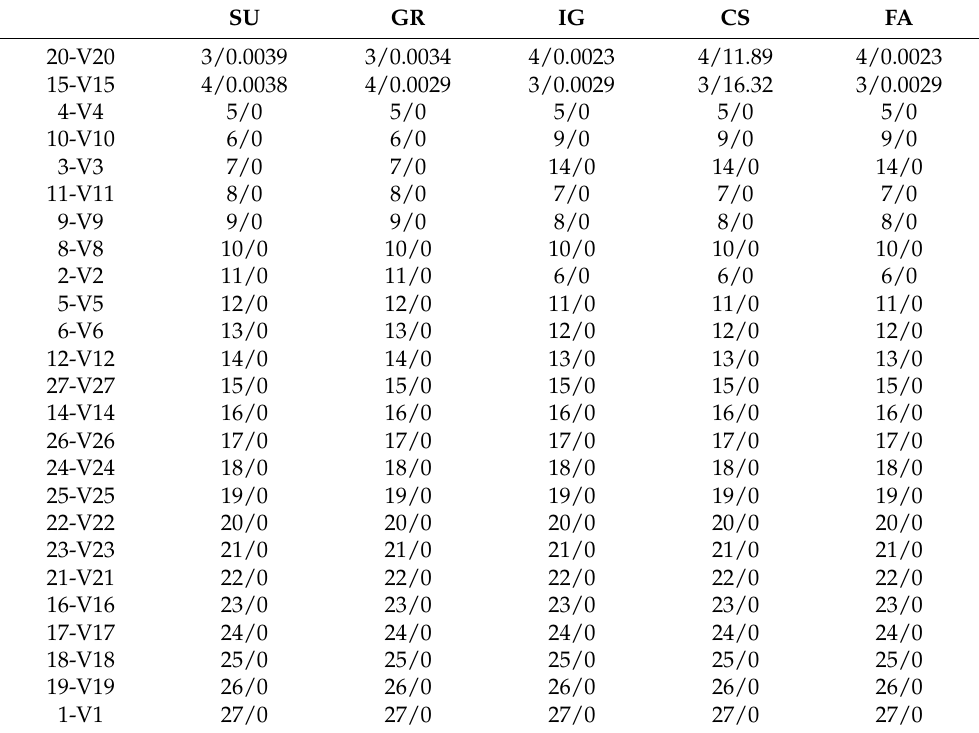
√ notates selection of